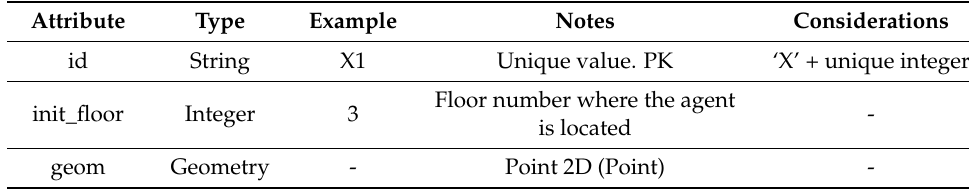
Table A6. GIS attribute table of statics.